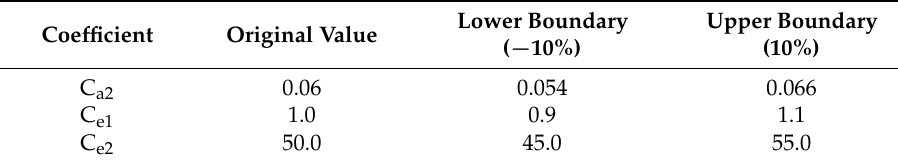
Table 2. The uniform distributions of the three model coefficients ± 10% deviation.